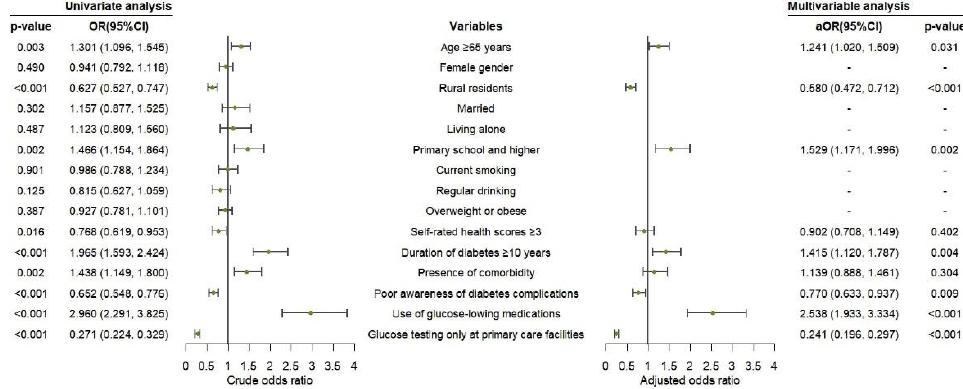
7 of 12 Figure 2. Logistic regression analysis on factors associated with regular follow-up attendance among T2DM patients at moderate to high CV risk. 3.4. Factors Associated with the Frequency of Blood Glucose Monitoring In the univariate analysis, age, place of residence, education level, self-rated health scores, duration of diabetes, presence of comorbidity, awareness of adverse consequences of diabetes complications, use of glucose-lowering medications, and venues for testing blood glucose were associated with the frequency of blood glucose monitoring ( p <0.05), which were further entered in the multivariable analysis. In the further analysis, the fol-